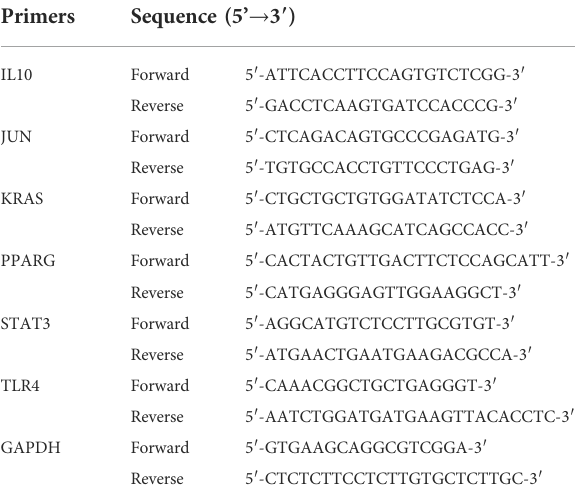
TABLE 2 Primers used in Quantitative